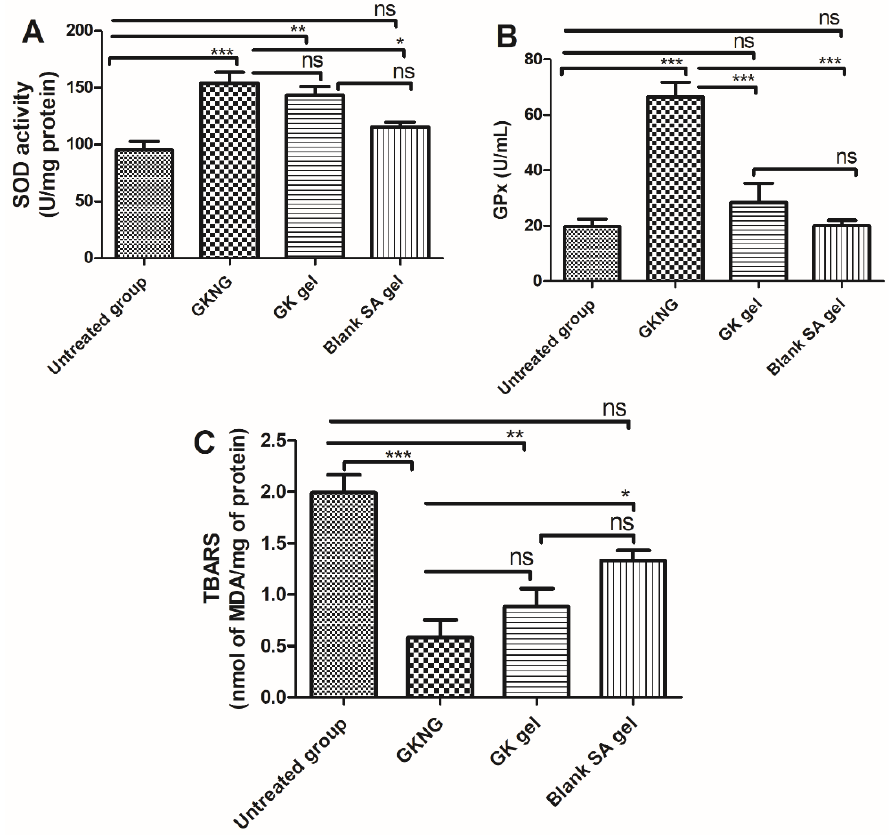
Figure 5. Effects of GKNG, GK gel, and blank SA gel on the markers of antioxidant enzymes ( A ) SOD, ( B ) GPx, and ( C ) MDA. Values are represented as mean ± SD (n = 4). Statistical analysis was performed by one-way ANOVA followed by Tukey’s multiple comparison test. ‘***’, ‘**’, and ‘*’ refer to p < 0.001, p < 0.01, and p < 0.05 and represent significant differences between the treatment and untreated groups. ‘ns’ refers to a nonsignificant difference between the treatment groups and untreated groups.